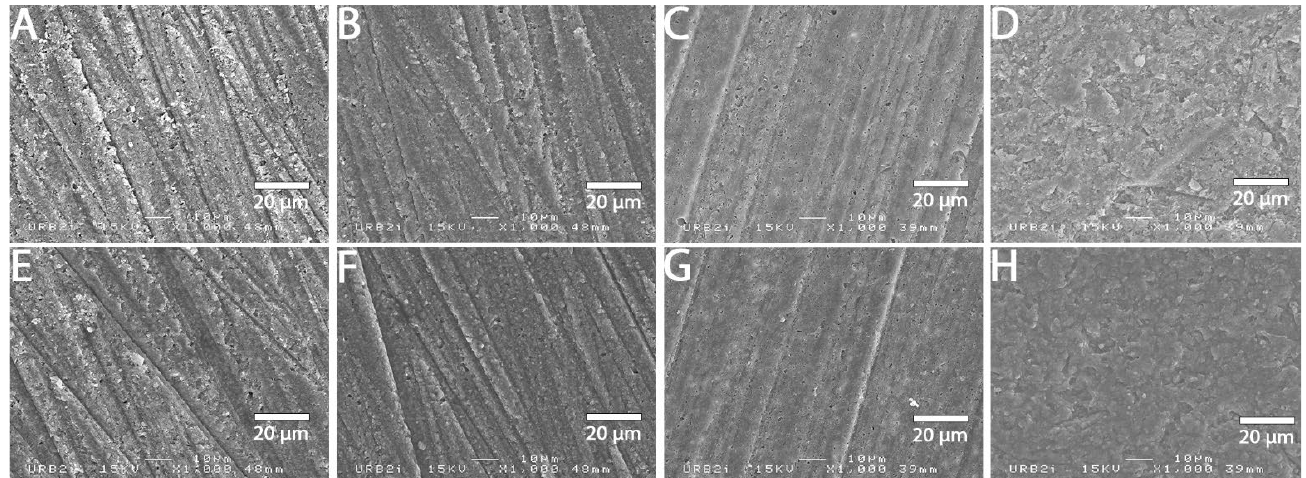
Figure 1. SEM micrograph for Brillant Crios surface (×1000 magnification) with the different surface treatments: ( A ) control; ( B ) polyacrylic acid; ( C ) hydrofluoric acid; ( D ) sandblasting; ( E ) 800 grit polishing + universal primer; ( F ) polyacrylic acid + universal primer; ( G ) hydrofluoric acid + universal primer; ( H ) sandblasting + universal primer. Sandblasting surface treatment ( D , H ) shows a more irregular pattern surface than the other ones.